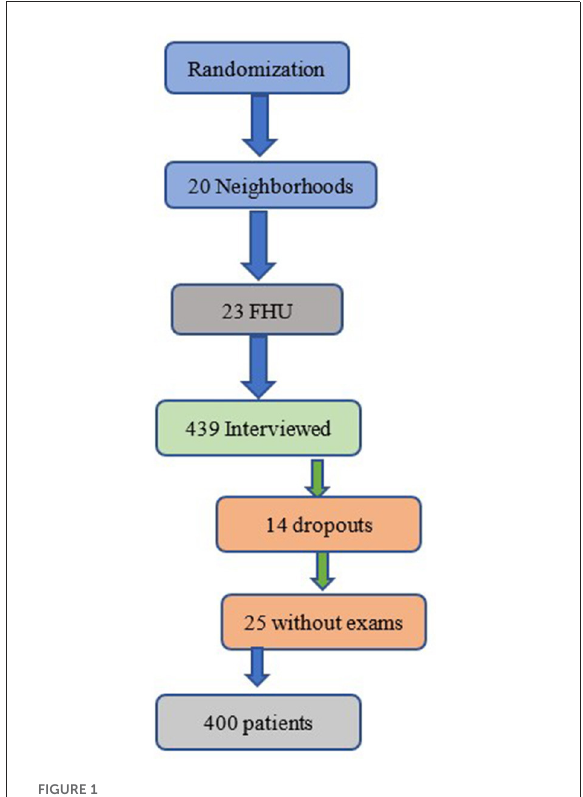
FIGURE1 Randomization number of neighborhoods, FHU, excluded (abandonments and without complete examinations) and the final sample of